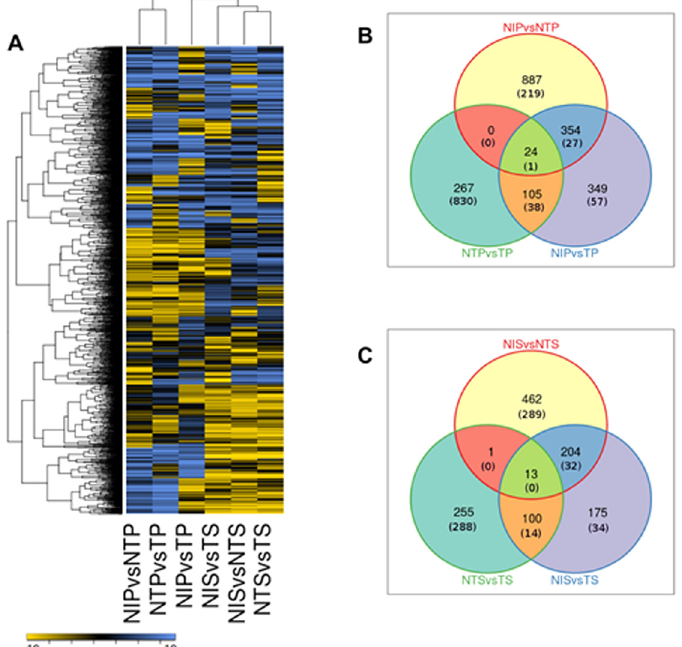
Fig 2. Gene expression profile of cotton in pericarp and seed tissue in response to A . flavus infection. A) Heatmap showing differentially expressed genes (DEGs) of cotton in response to infection by atoxigenic and toxigenic strains of A . flavus . The up-regulated genes (log2FC > = 2 and P < 0.05) and down-regulated genes (log2FC < = -2 and P < 0.05) are represented by blue and yellow color, respectively. Genes with similar expression profiles were clustered together by hierarchical clustering. For description of the gene names represented in the heatmaps please refer to the S1 Table, sheet 2. Venn diagram shows the unique and common DEGs in pericarp (B) and seed (C) tissues under different experimental conditions.